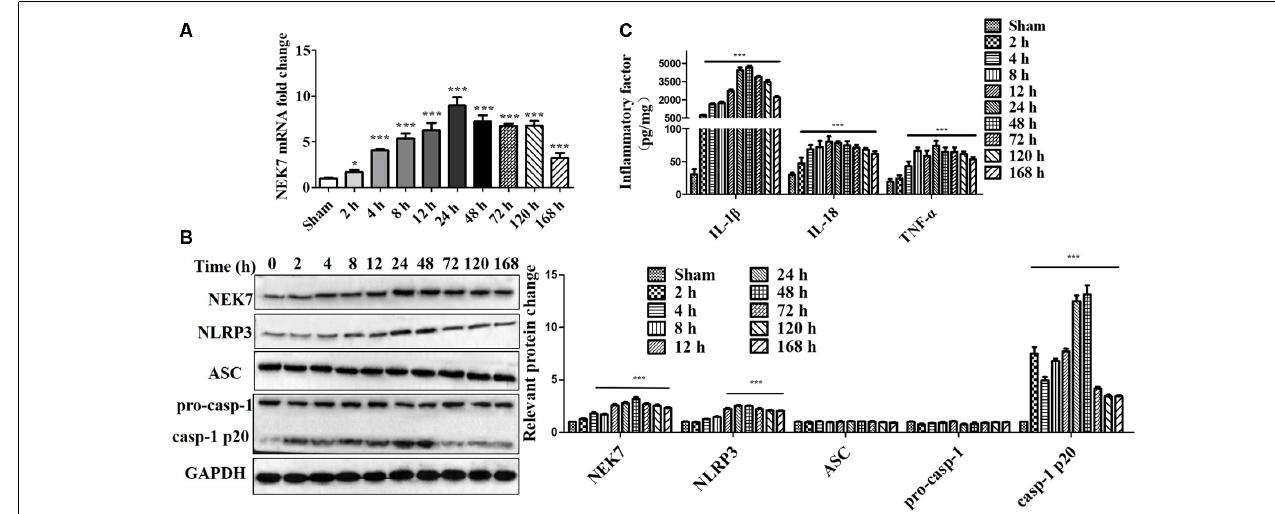
FIGURE 1 | Time course of NIMA-related kinase 7 (NEK7) and nucleotide-binding oligomerization domain, leucine-rich repeat and pyrin domain-containing 3 (NLRP3) inflammasome in the acute phase post-traumatic brain injury (TBI). (A) Time course of NEK7 mRNA expression was analyzed during 168 h post-TBI, n = 10. (B) NEK7, NLRP3, apoptosis-associated speck-like protein containing CARD (ASC) and caspase-1 expression were detected during 168 h post-TBI, n = 6. (C) Time course of interleukin-1 β (IL-1 β ), IL-18, and TNF- α levels during 168 h post-TBI, n = 10. Data are represented as the mean ± SEM. ∗ p < 0.05, ∗∗∗ p < 0.001, vs.